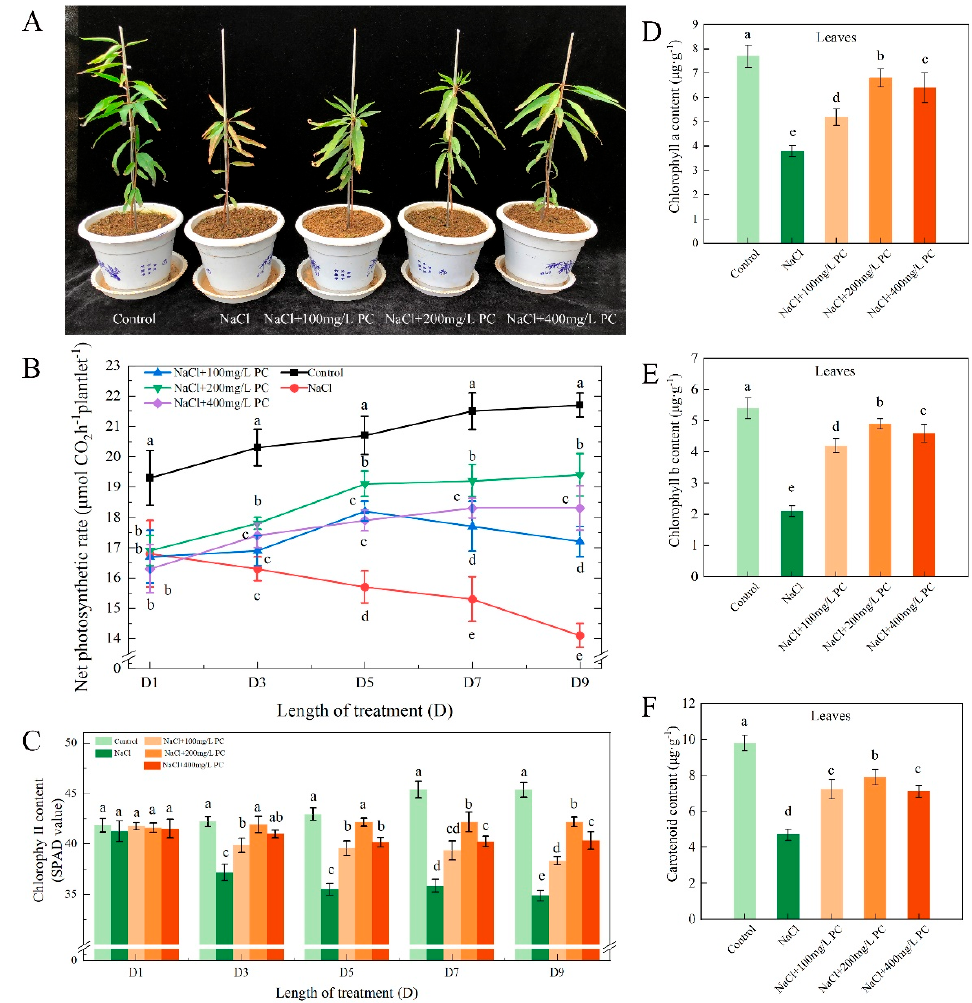
Figure 1. Plant photosynthetic system parameters under salt stress. ( A ) Peach seedlings under salt stress; ( B ) Net photosynthetic rate; ( C ) Chlorophyll content in 1–9 days; ( D – F ) Chlorophyll a, b, and carotenoid content on the ninth day. The photos in Figure 1A were taken on the 11th day under salt stress. The error bar represents the standard deviation of the mean ( n = 3). Different lowercase letters indicate significant differences among treatments (Duncan test, 21.7%, 22.9%; p < 0.05).